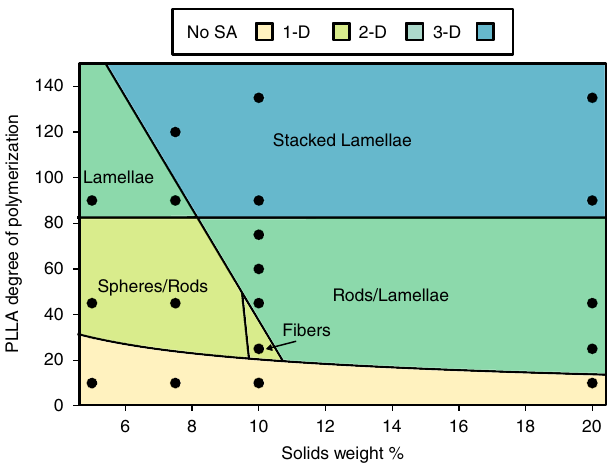
Fig. 5 ROPI-CDSA phase diagram. The phase diagram shows hierarchical ordering for samples 1 – 19 (Table 1). No SA refers to no self-assembly observed. The phase diagram shows a clear trend where higher dimensional structures are favored at higher solids content and higher PLLA